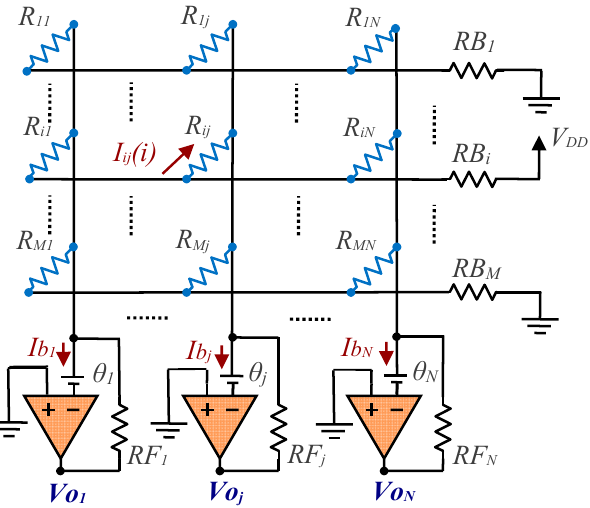
Figure 2. Implementation of the resistor array reading circuit with operational amplifiers (OAs).